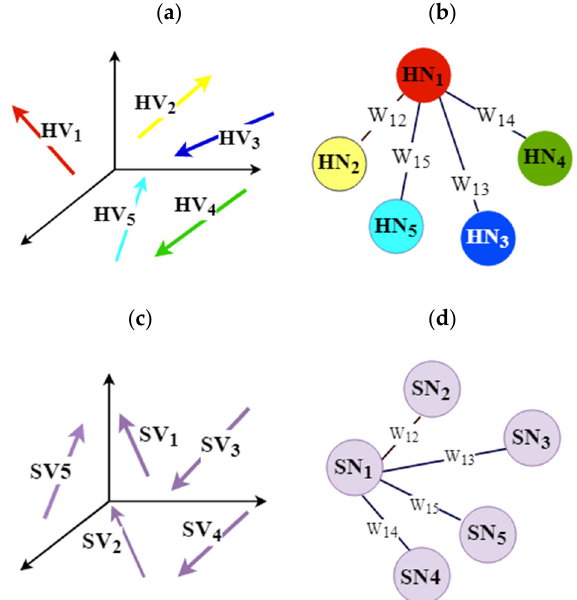
Figure 4. Transformation of 3D vectors into the weighted fully connected graph: ( a ) α -helix vectors in R 3 ; ( b ) construction of the weighted fully connected graph of α -helices ( G SSEs − A ). The i th helix vector (HV i ) is transformed into an i th helix node (HN i ); ( c ) stick vectors in R 3 ; ( d ) construction of the weighted fully connected graph of sticks ( G SSEs − C ). The i th stick vector (SV i ) is transformed into the i th stick node (SN i ).